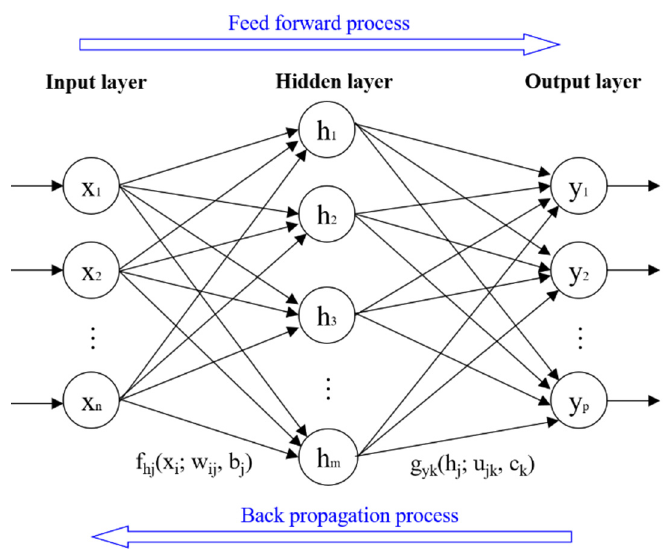
Figure 1. The structure of a typical ANN.